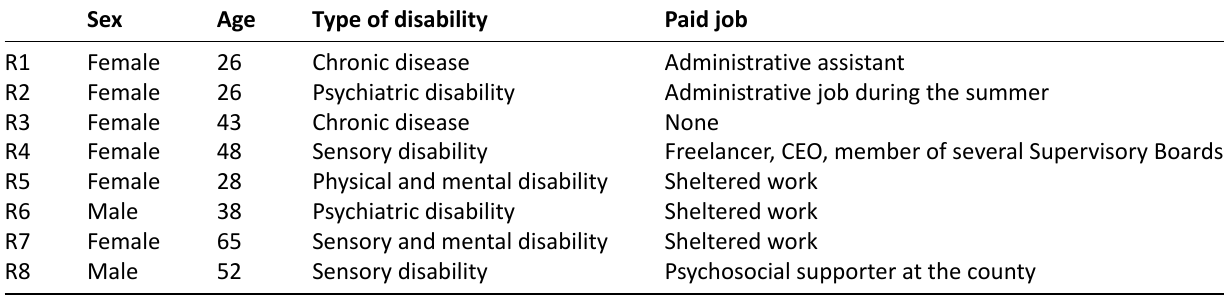
Table 1. Demographic information about the participants with a work-relevant disability. Sex Age